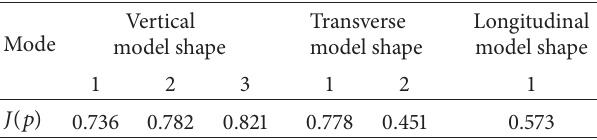
Table 14: Overlap ratio index of each modal frequency with the average absolute value of relative errors.